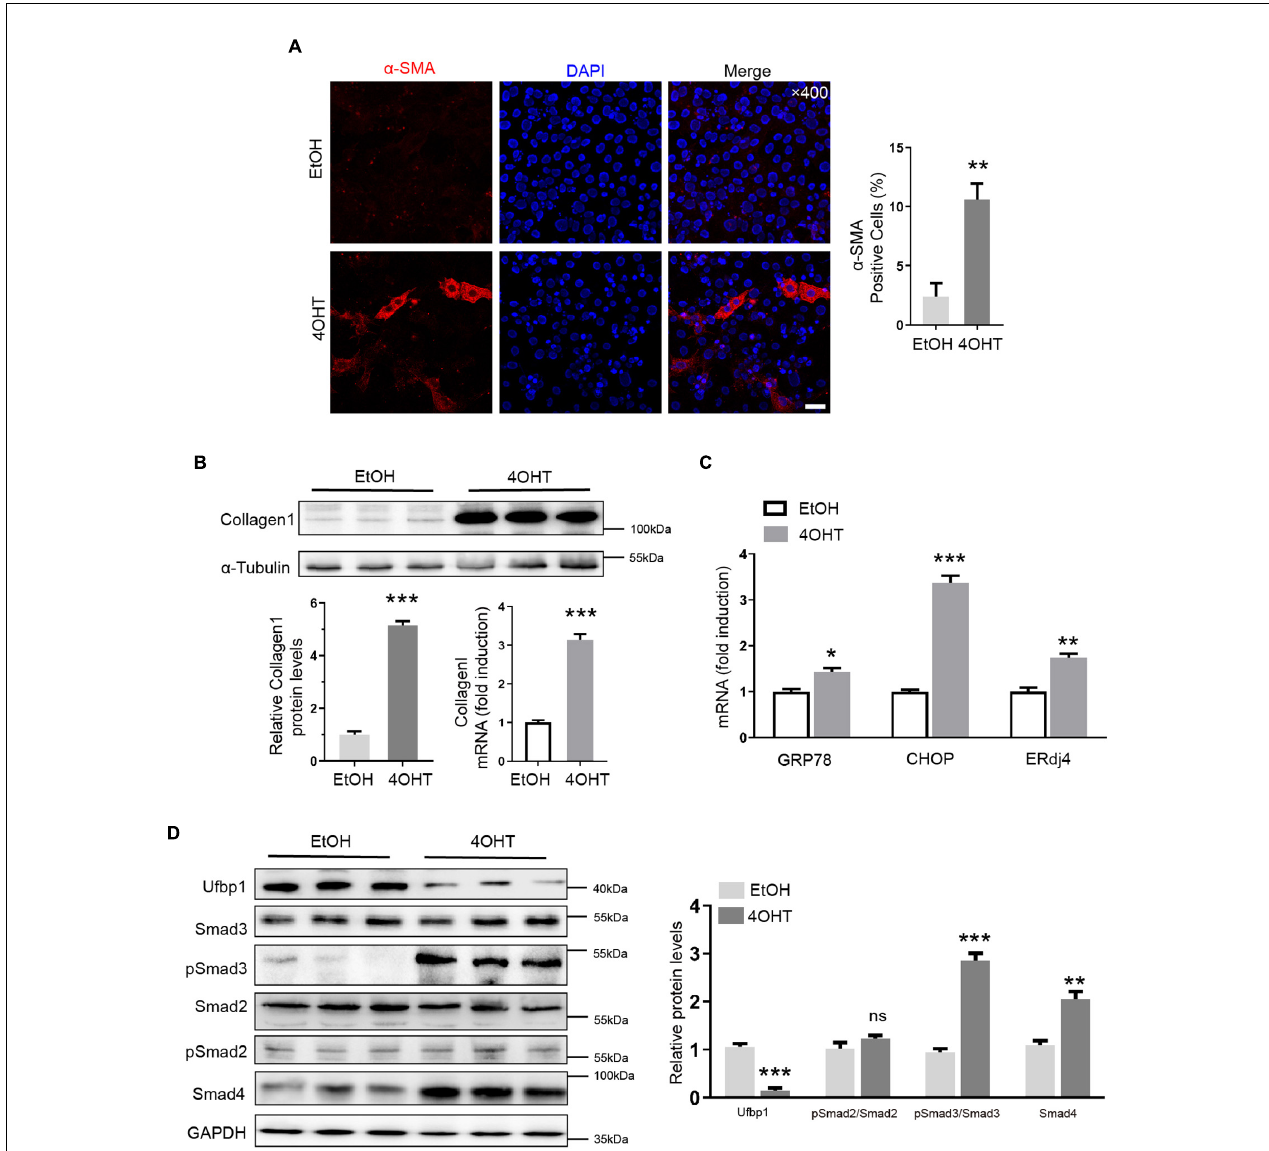
FIGURE 5 | Ufbp1 deletion induced fibrotic response, Smad3 activation, and elevated ER stress in MEFs. (A) α -SMA expression was indicated by immunofluorescence (red). (B) RT-qPCR and Western blot analysis for Collagen1 ( n = 3). (C) Upregulation of ER stress markers including GRP78, ERdj4, and CHOP ( n = 3). (D) Elevation of phosphorylation of Smad3 and Smad4 expression in Ufbp1-deficient of MEFs, and quantitative analysis was shown in lower panel ( n = 3). Data are presented as means ± SEM, * P < 0.05, ** P < 0.01, *** P < 0.001 ( n = 3). Scale bar = 20 µ